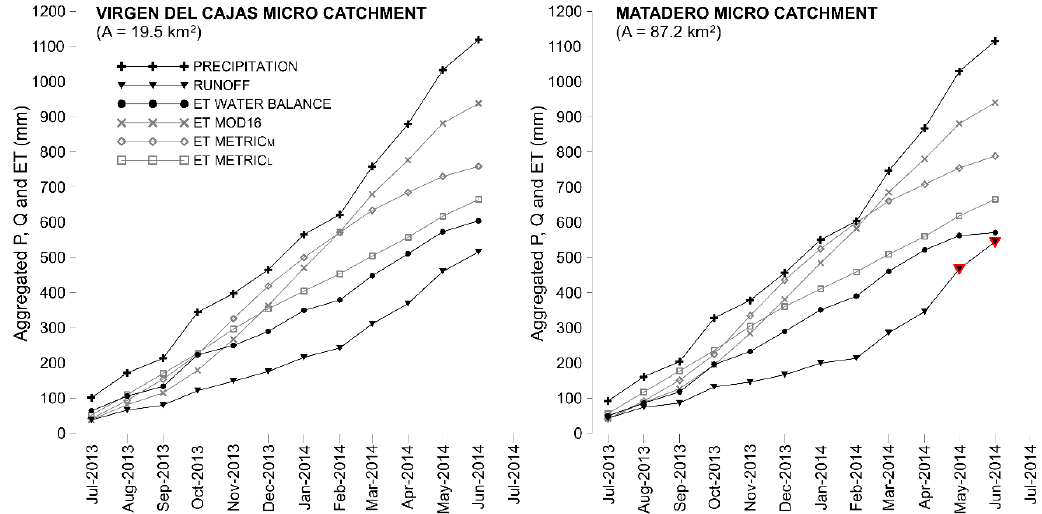
Figure 9. Aggregated precipitation, runoff and residual ET in comparison with METRIC L , METRIC M and MOD16 ET. Noticeable runoff increments are highlighted in red color.